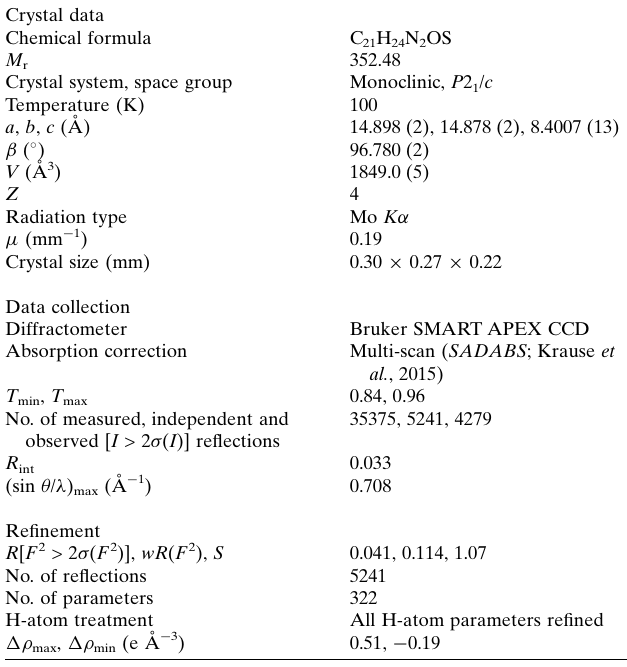
Table 1 Hydrogen-bond geometry (A˚ , (cid:2)